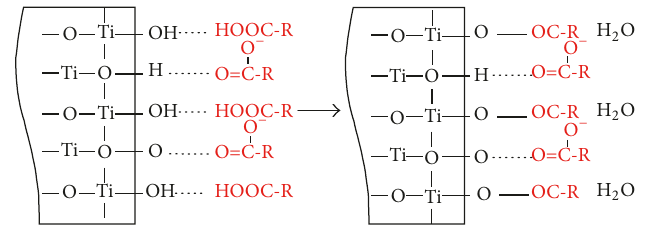
Figure 10: Schematic diagram of TiO 2 modified by sodium stearate and sodium